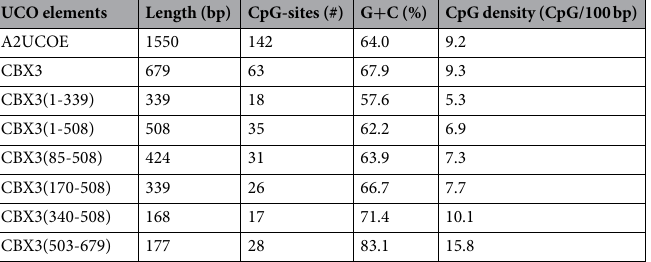
Table 1. Structural attributes of the A2UCOE, CBX3 and CBX3 subfragments. bp, base pairs; #, number